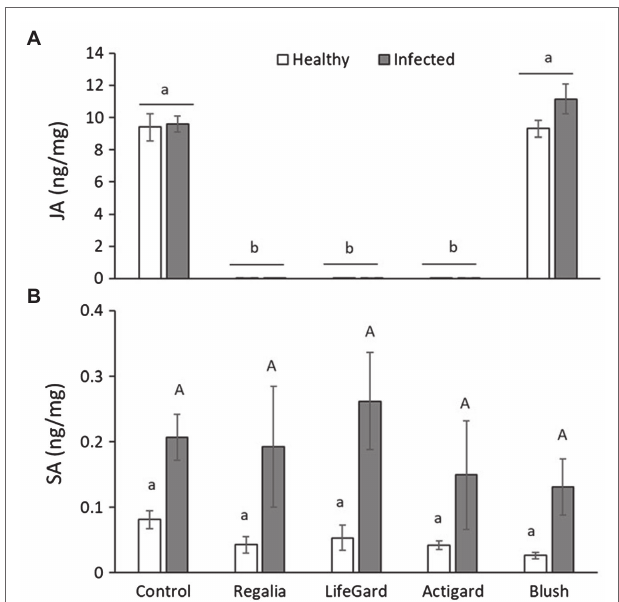
FIGURE 6 | Effects of phytoplasma infection and elicitor treatments on levels of the phytohormones jasmonic acid (JA) (A) and salicylic acid (SA) (B) in cranberry plants. Data are means ± SE . Different lowercase letters above bars indicate that means among elicitor treatments differ for uninfected (healthy) plants, and different uppercase letters show treatment differences for infected plants (Tukey’s HSD tests, p ≤ 0.05). Control plants did not receive any elicitor (i.e., treated with distilled water only). n = 4 replicates per infection/treatment